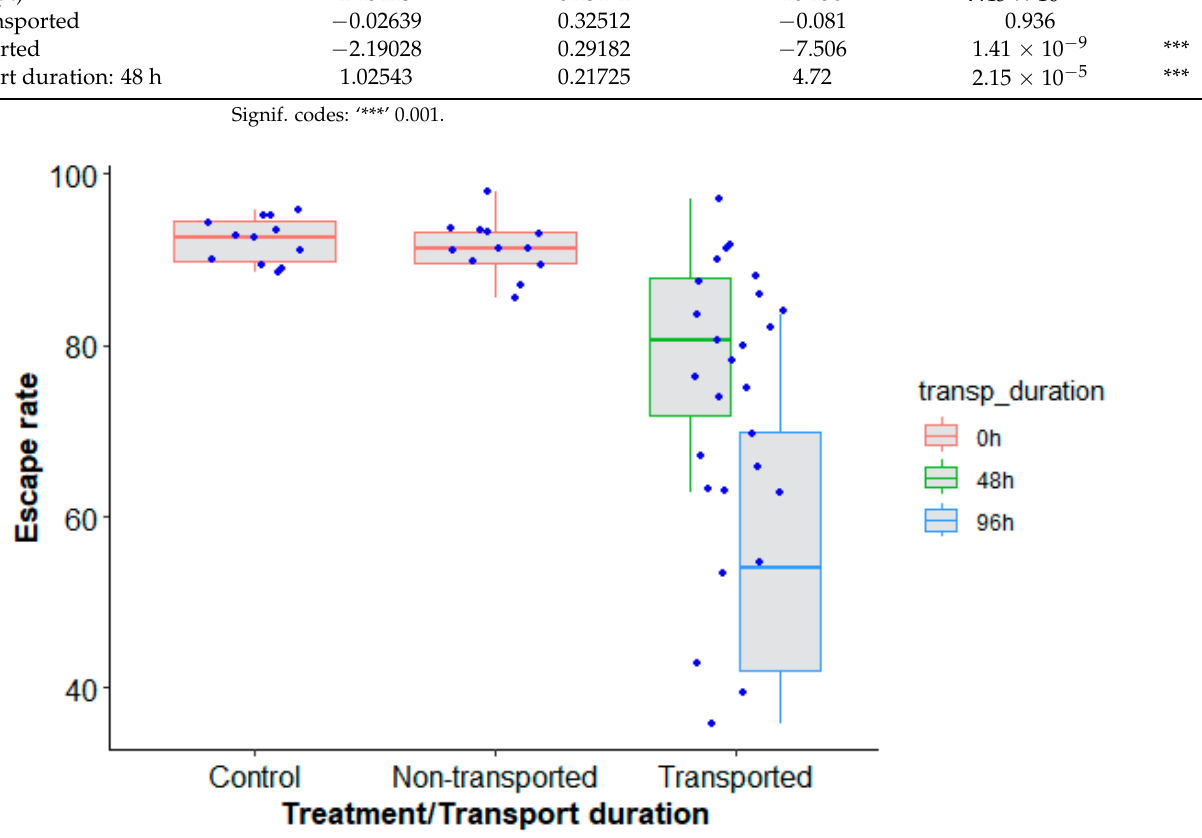
Table 4. Fixed effects of mosquito treatments (transported and nontransported) and the duration of transport (48 h and 96 h) on Aedes aegypti , Senegal strain, escape rate after long-distance transport. Estimate Std. Error